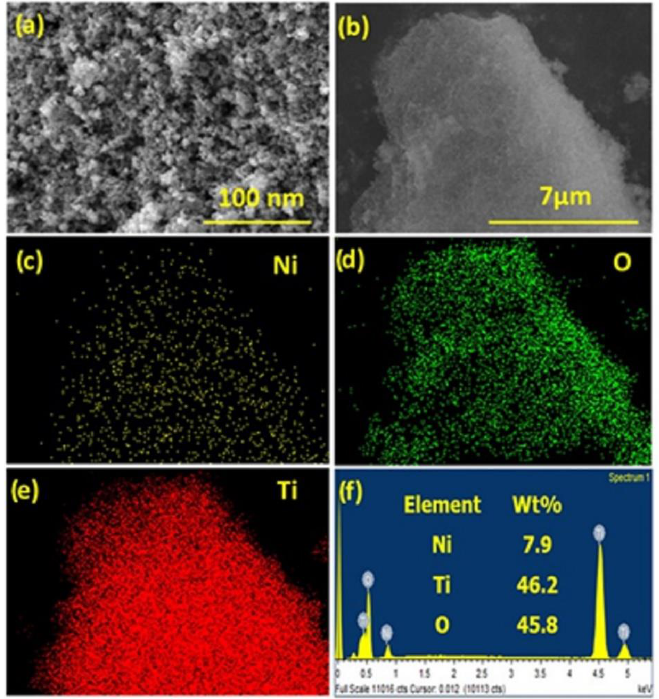
Figure 3. ( a , b ) SEM images, EDX mapping of ( c ) Ni, ( d ) O, ( e ) Ti, and ( f ) EDX spectrum of 7.5Ni/m-TiO 2 .